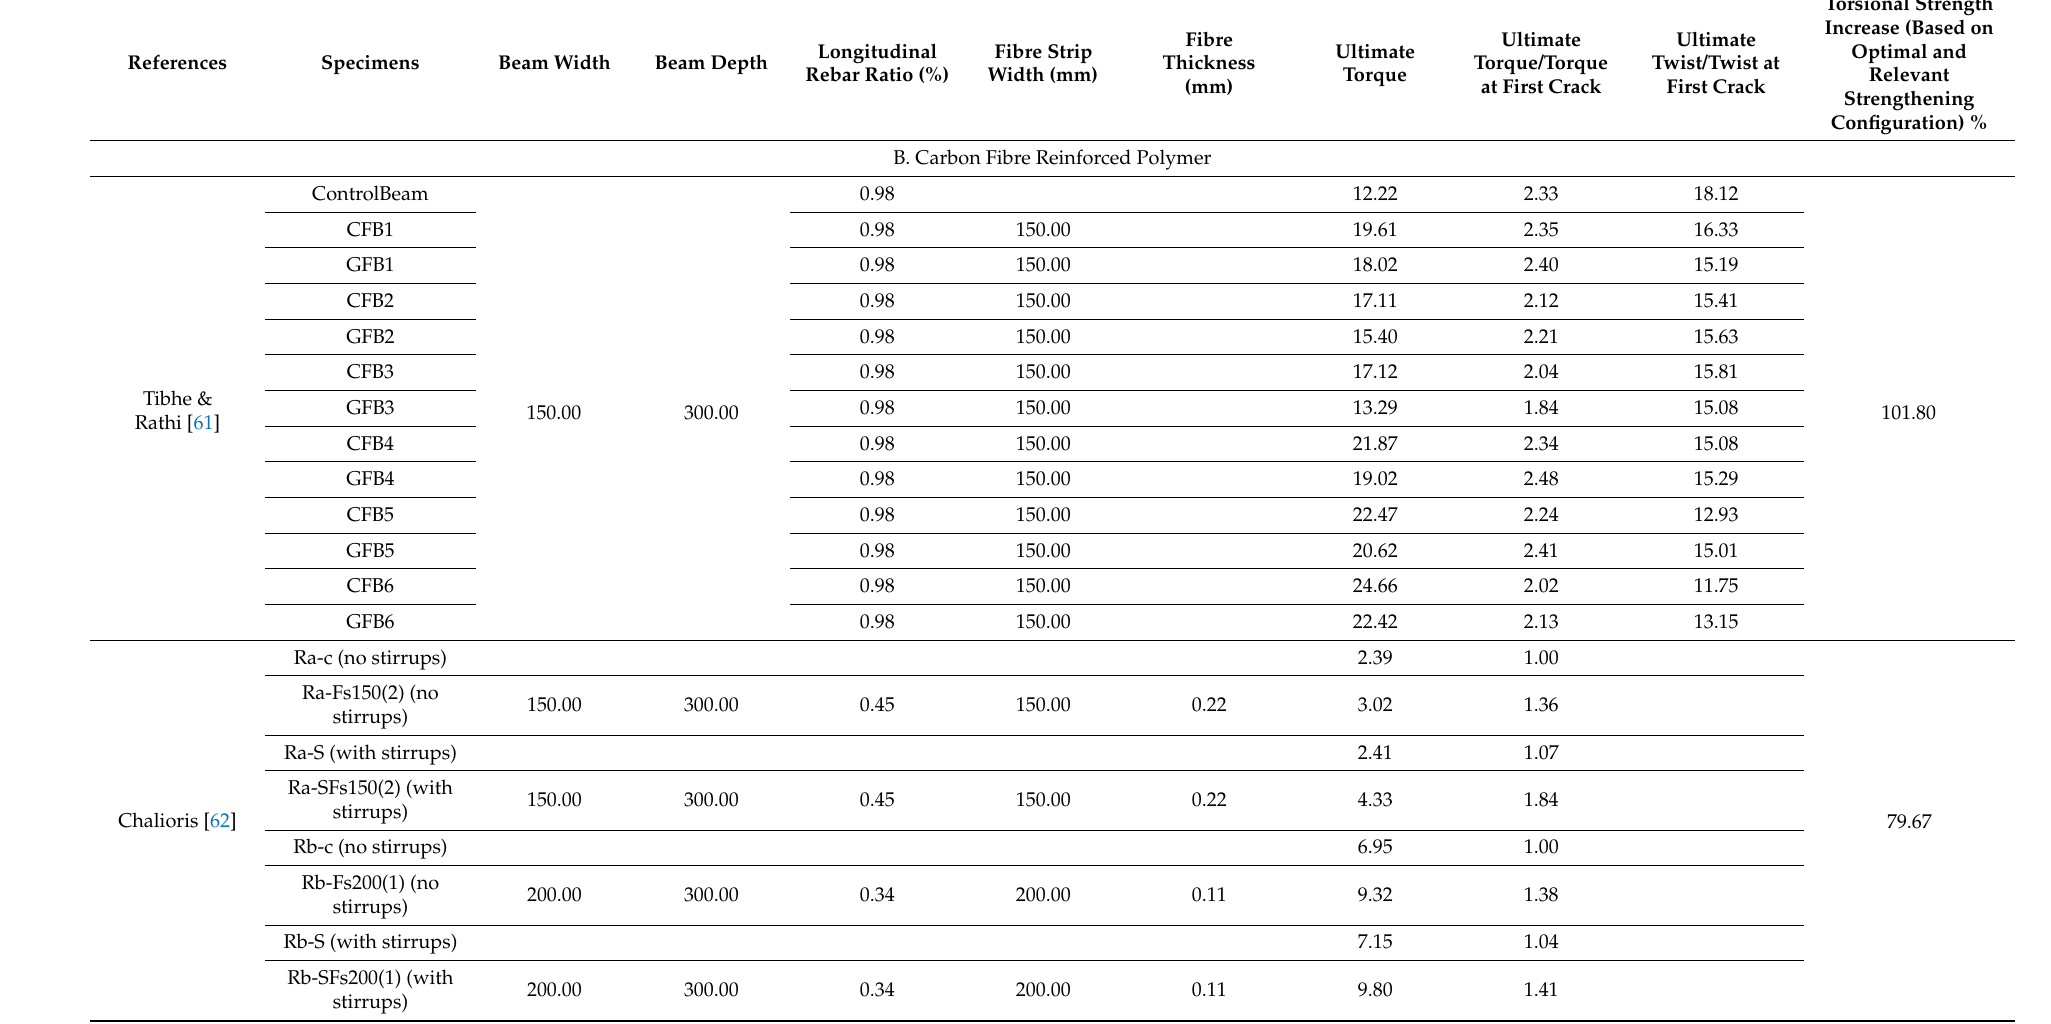
Table 12. Experimental findings on carbon fibre reinforced polymer